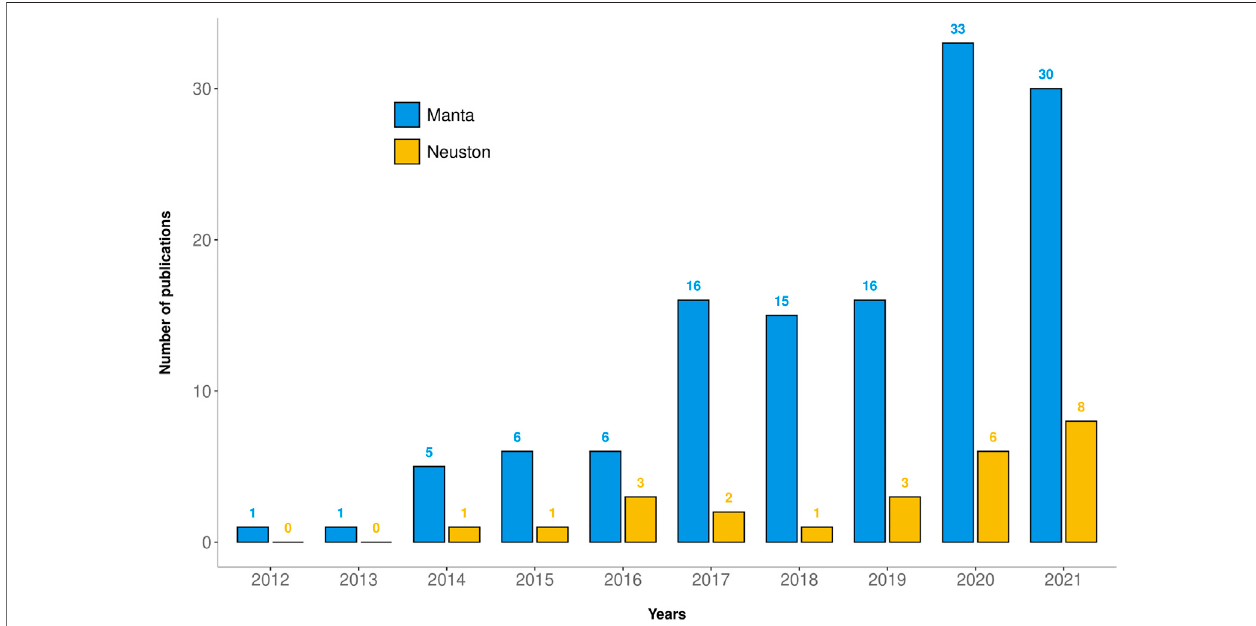
FIGURE 1 | Number of publications per year using the Manta net (blue) or the Neuston net (yellow) as a sampling method for microplastics on the water surface during the last decade.